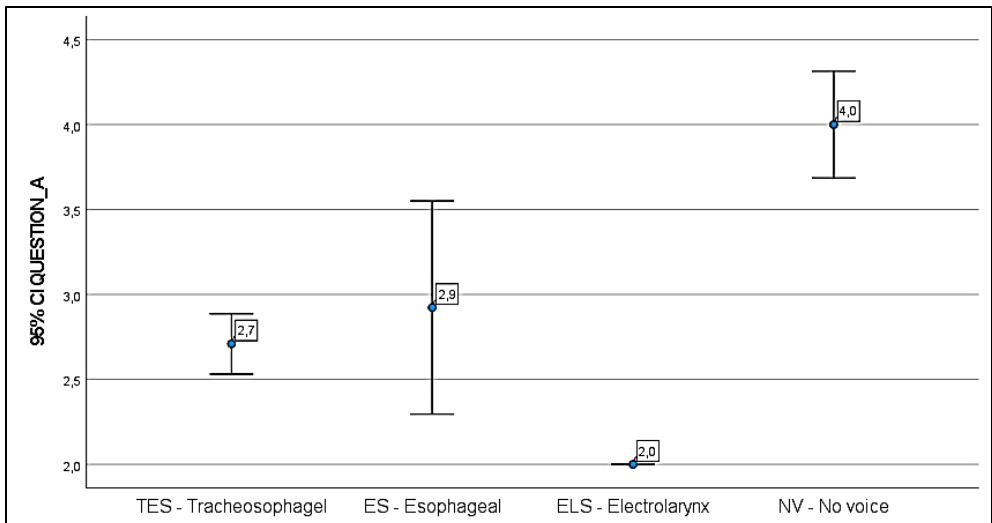
Figure 2. Question A: circle represents the mean, bars represent 95% CIs, labels report the mean. Score legend: 1: no problem; 2: some; 3: moderate; 4: marked; 5: severe.